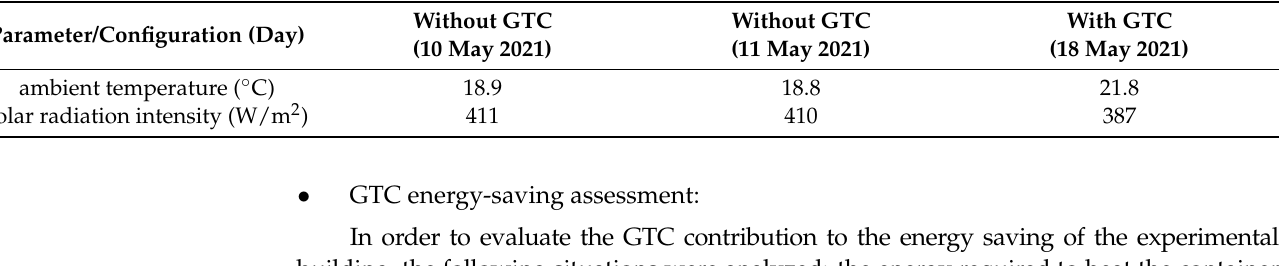
Table 7. Days chosen for analysis: weather data (average values).